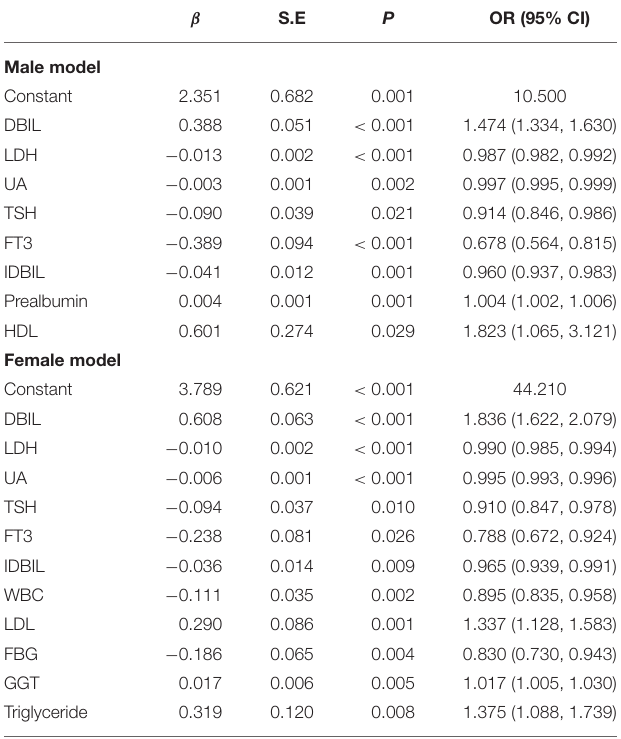
TABLE 2 | Regression analysis for diagnostic predictors to BD vs.